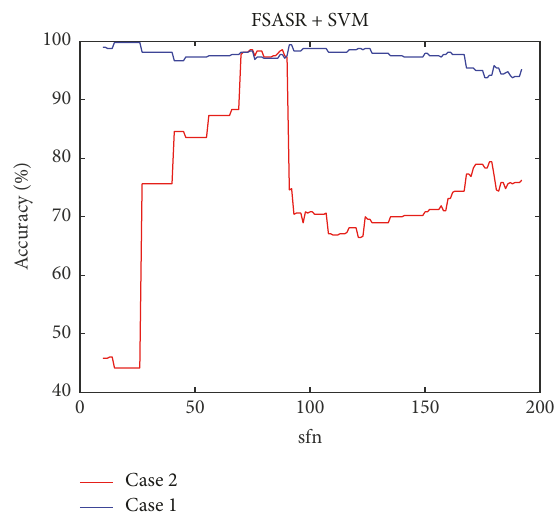
Figure 11: The diagnosis results of OFS-FSASR-SVM using WPT with different